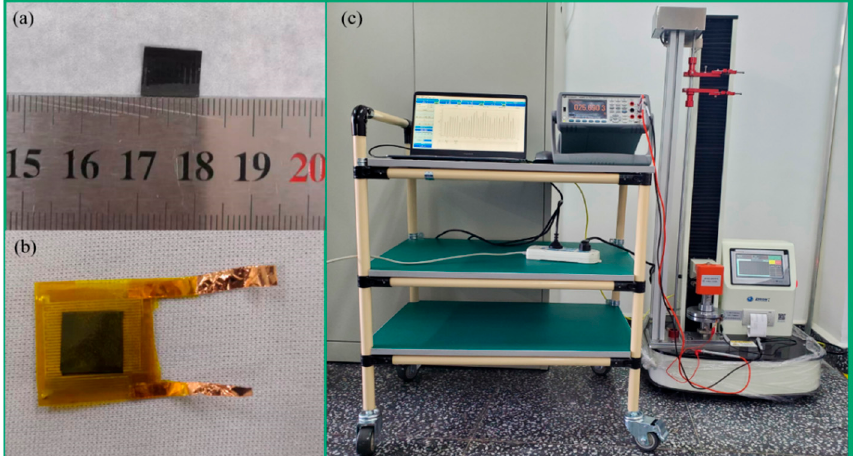
Figure 4. Preparation process of the MCNF flexible piezoresistive sensor.